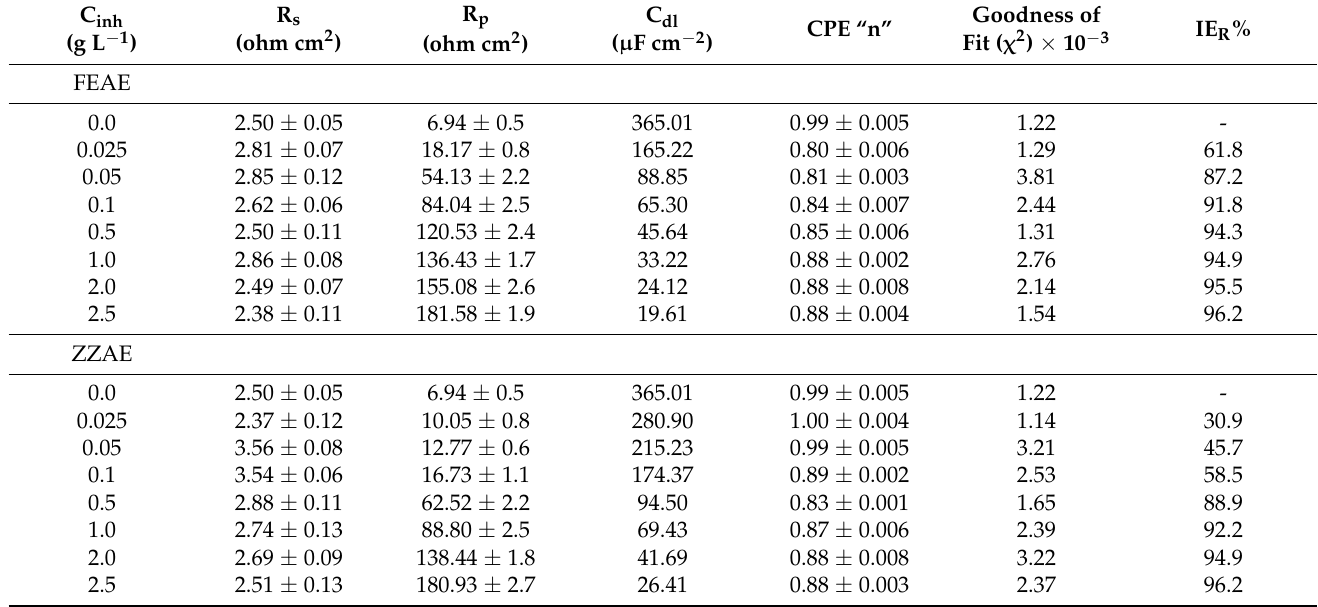
Table 3. Impedance parameters obtained from mild steel corrosion in 2 M H 3 PO 4 with and without different concentrations of the studied plant extracts at 30 ◦